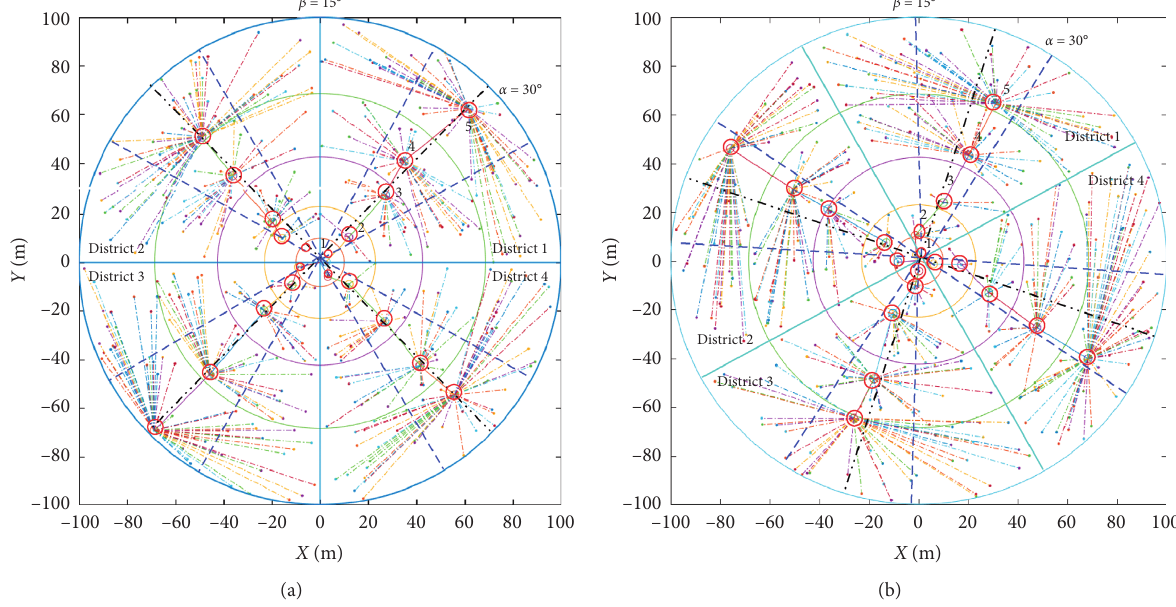
Figure 4: Illustration of network communication. (a) Nonrotation and (b) 45 th